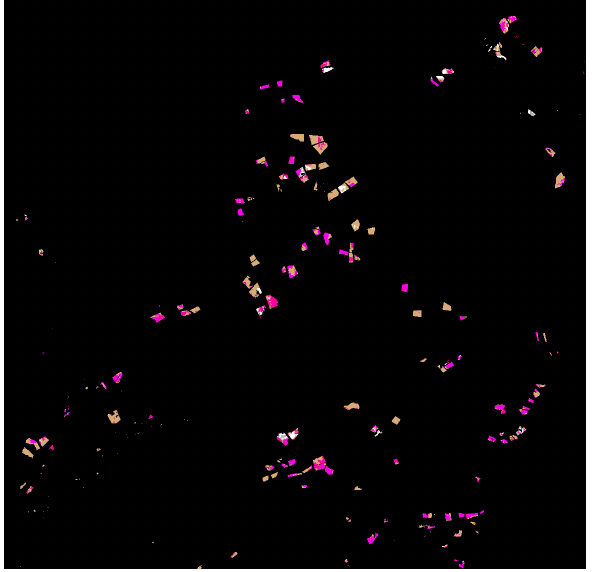
Figure 6. STL-map of the r 1 pattern, for areas identified as pastures by the DSLCC, in the region of la Plaine des Cafres